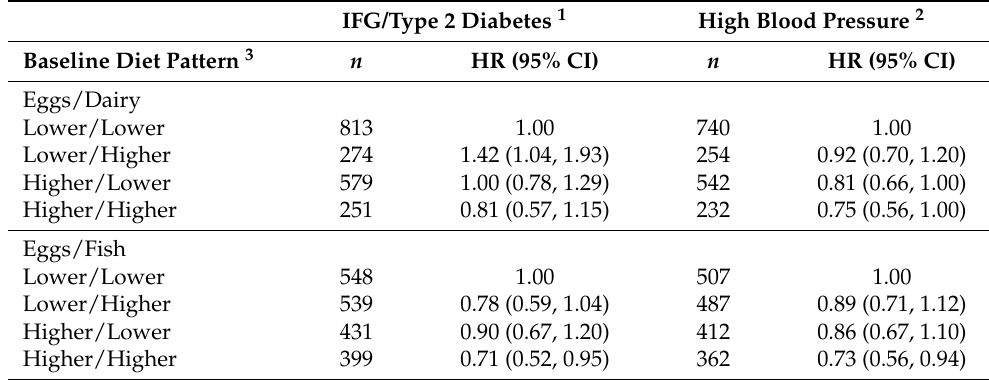
Table 5. Effects of egg-related diet patterns on risks of impaired fasting glucose and high blood